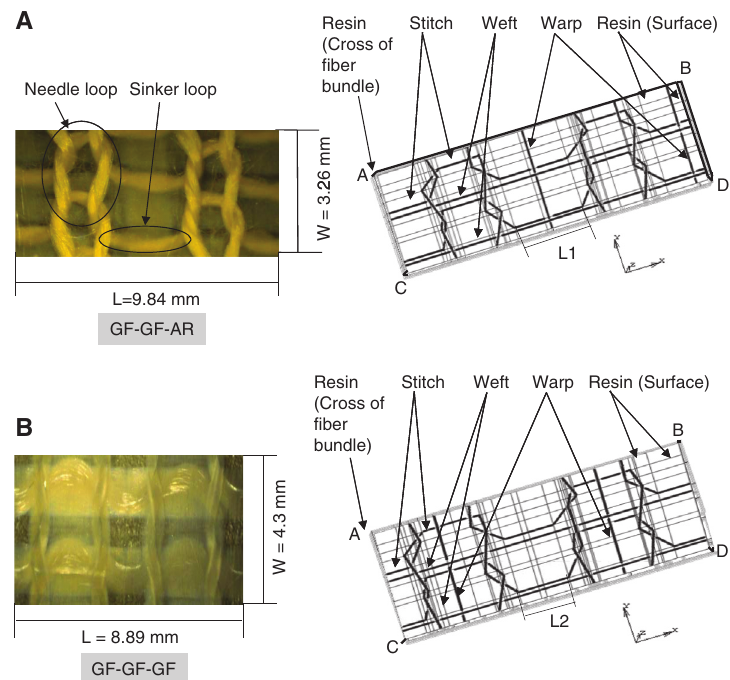
Figure 4 (A) Actual structure of the composite in the wale direction (left) and the FEM of the GF-GF-AR composite in the wale direction (right); (B) actual structure of the composite in the wale direction (left) and the FEM of the GF-GF-GF composite in the wale direction (right).